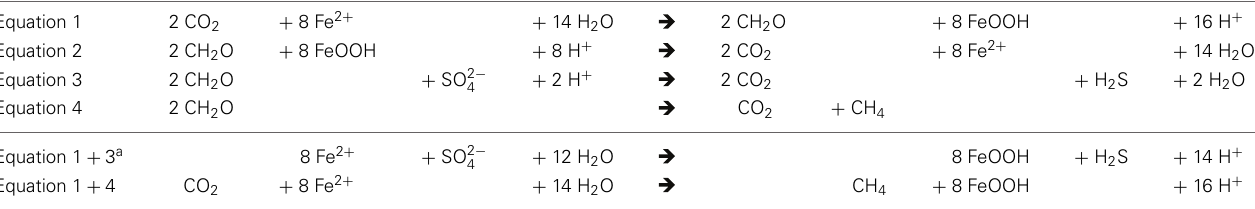
Table 1 | Simplified stoichiometries of photoferrotrophic primary production (Equation 1) and different anaerobic modes of organic matter degradation (Equation 2: Fe(III)-respiration, Equation 3: sulfate-respiration, Equation 4: methanogenesis). Equation